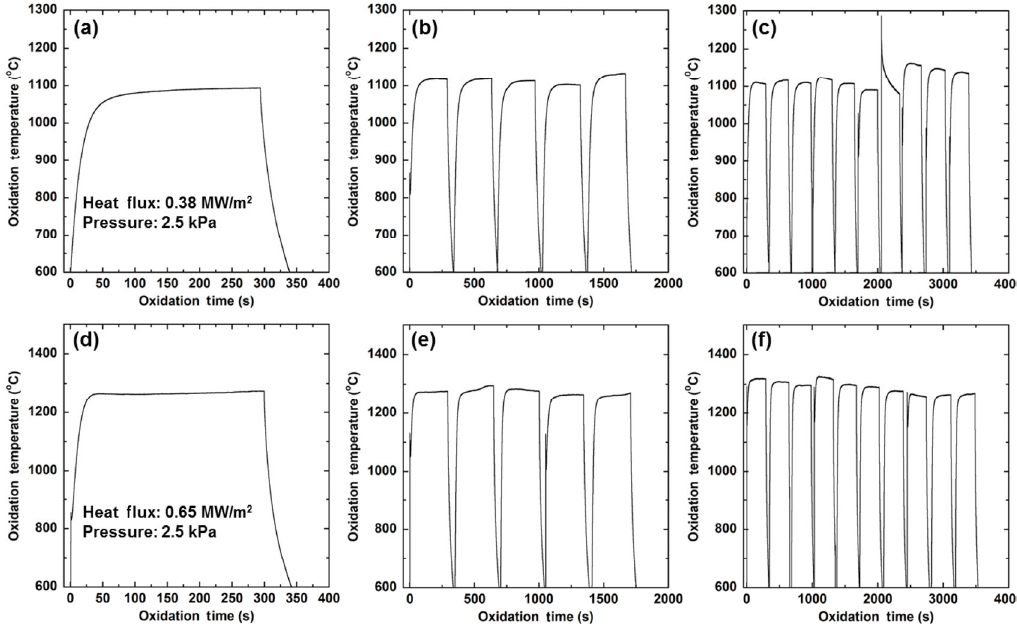
Fig. 9 Surface temperature evolution of C f /SiC “dog-bone” specimens at ~2.5 kPa at (a–c) ~0.38 MW/m 2 and (d–f) ~0.65 MW/m 2 with 1, 5, and 10 times plasma exposures,